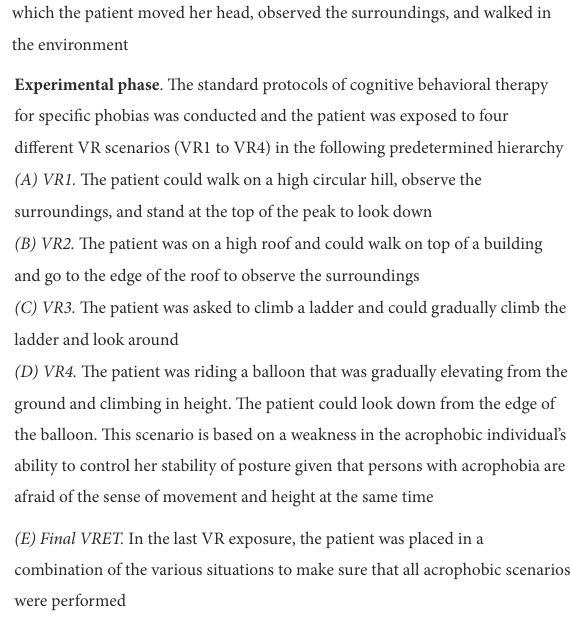
TABLE 2 The VRET protocol for specific